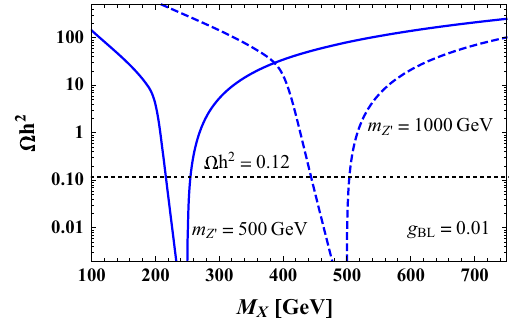
Fig. 3 The relic density of dark matter X as a function of m X where solid (dashed) lines correspond to m Z (cid:2) = 500 ( 1000 ) GeV and g BL = 0 . 01 is applied as the allowed sampling point